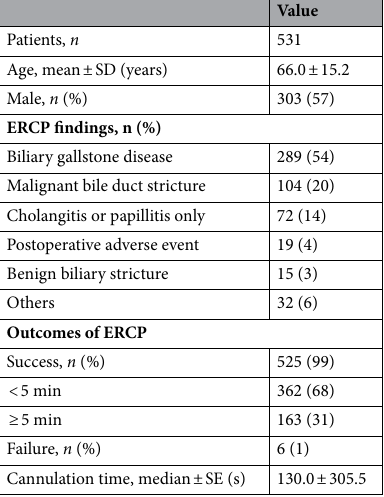
Table 1. Baseline characteristics of the enrolled patients who underwent ERCP. ERCP endoscopic retrograde cholangiopancreatography, SD standard deviation, SE standard